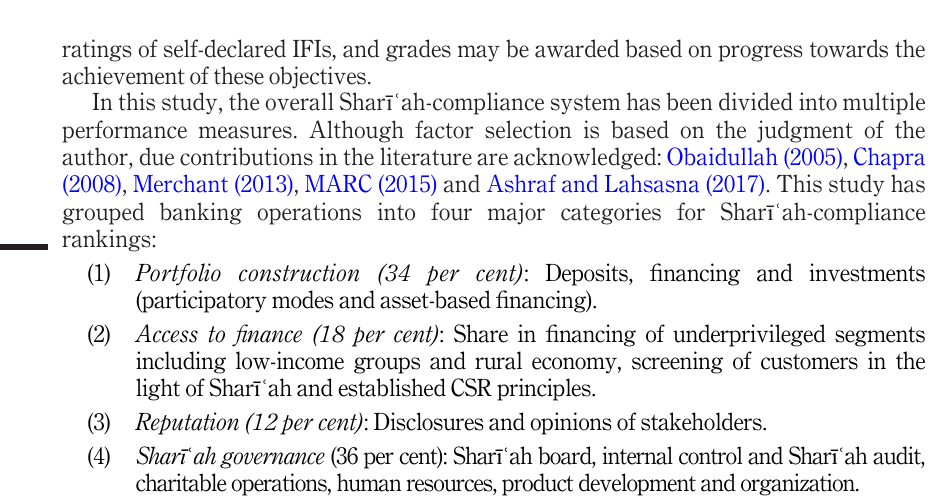
Broad grouping Portfolio